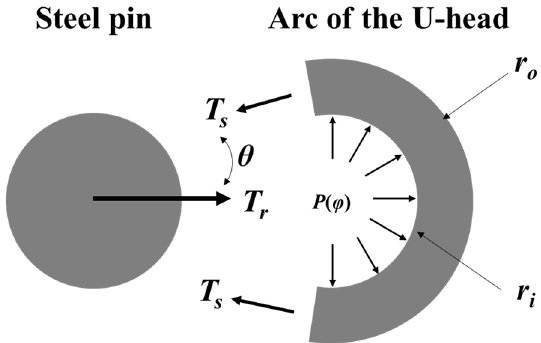
Figure 6. The thick-shell model.